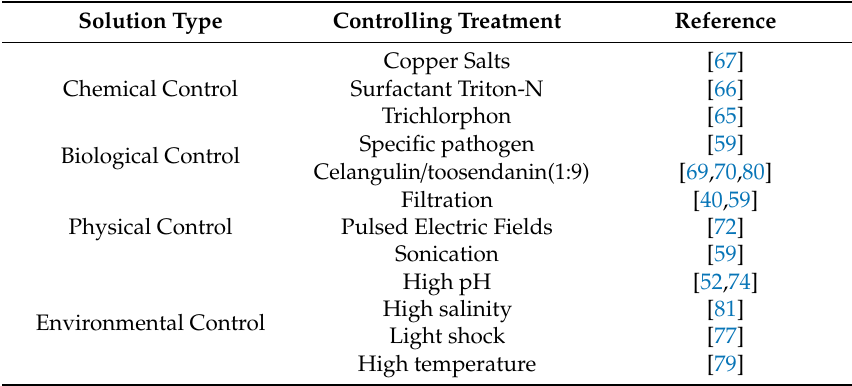
Table 2. Four categories of solutions to control the biological